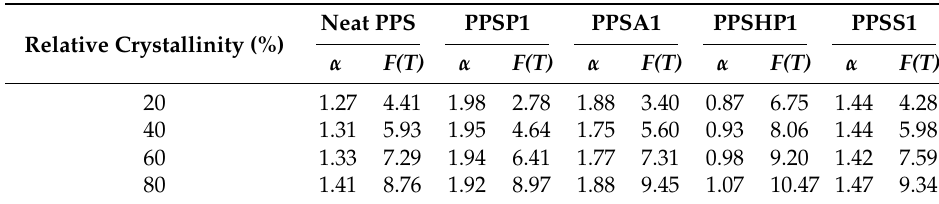
Table 3. Non-isothermal kinetic parameters of the PPS/MWCNTs composites at different relative crystallinity using the Avrami-Ozawa combined equation.